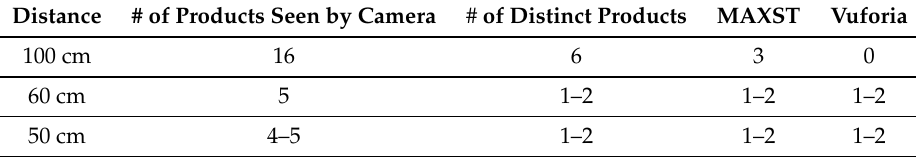
Table 3. The number of box-type products simultaneously recognized and tracked in the store.